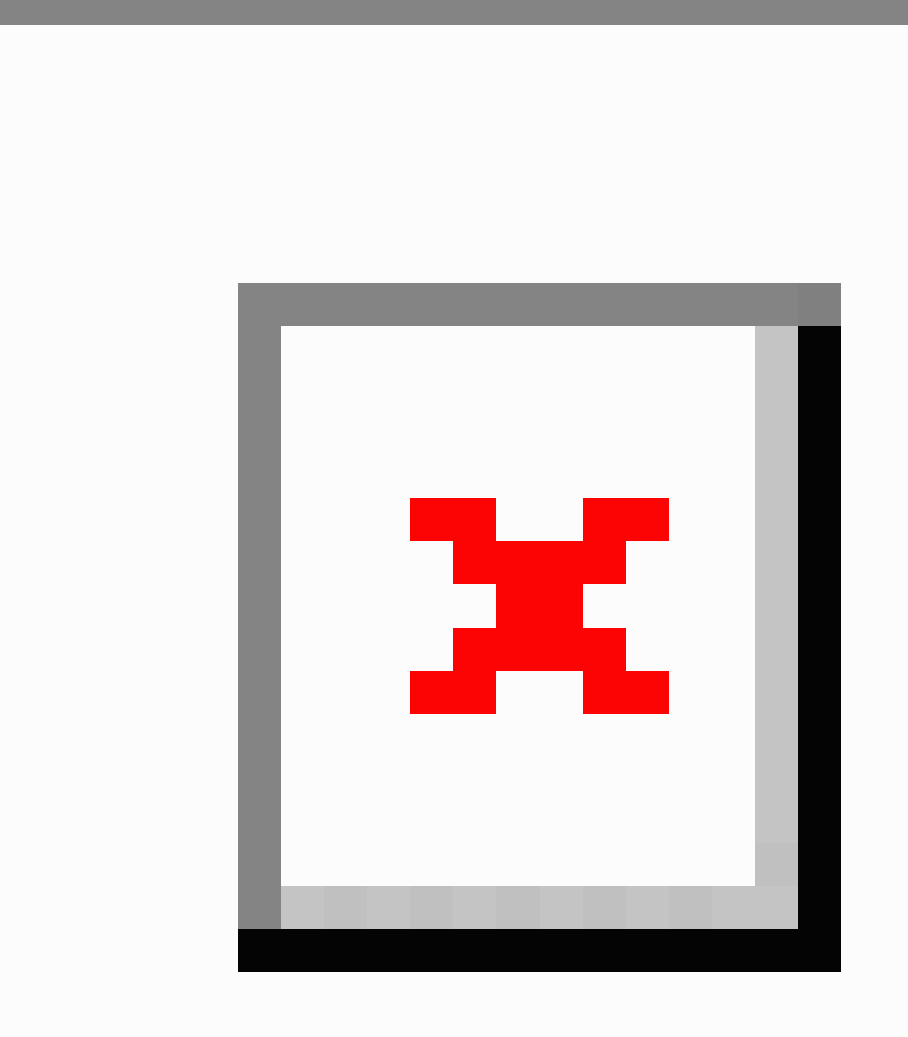
Figure 2. Screenshots and features of Children Eating Well smartphone app